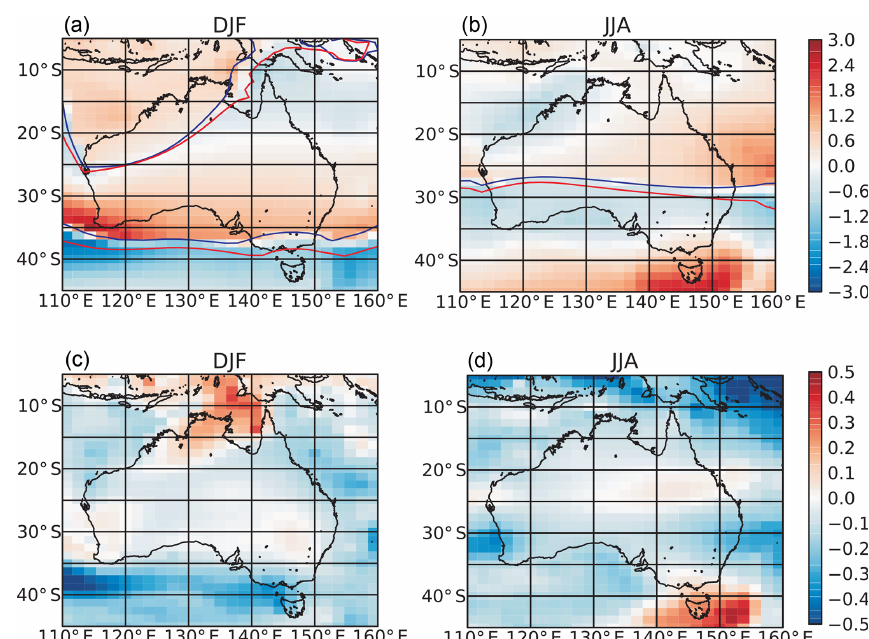
Figure 10. (a, b) CC-A modelled changes in wind speed for DJF and JJA with the zero of zonal wind speed shown as a contour in blue for current climate and red for future climate. (c, d) Standard deviation of wind speed for DJF and JJA as modelled by